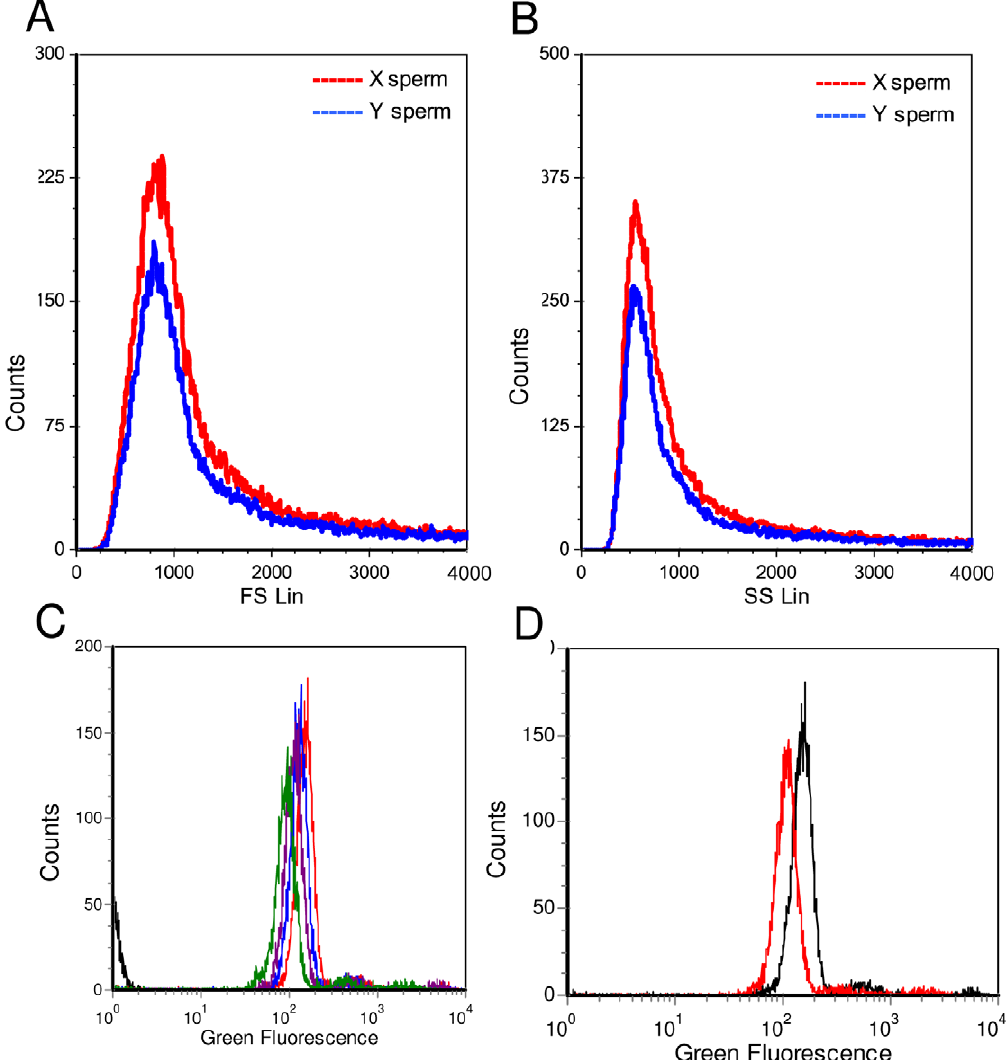
Figure 3. Uniform Venus fluorescence of X and Y chromosome bearing spermatozoa. A), B) Venus fluorescence (forward and side signal) of oriented sperm from boar # 503, after flow cytometric separation in X and Y chromosome bearing populations. C) Flow cytometric measurement of Venus-fluorescence in sperm of transposon transgenic boar # 503 at four time points (0 min (red line, 30 min (blue line), 60 min (lilac line), 180 min (green line) of exposure to blue LED light, and a non-transgenic control boar sample (black line on the very left). Mean fluorescence intensities: Wt=1. # 503 (0 min=153, 30 min=130, 60 min=113, 180 min=93). D) Decrease of Venus fluorescence intensity in whole semen after long-term storage. Venus fluorescence was assessed directly after isolation (black line) and after storage at 4 u C for four weeks (red line). doi:10.1371/journal.pone.0027563.g003 PLoS ONE |